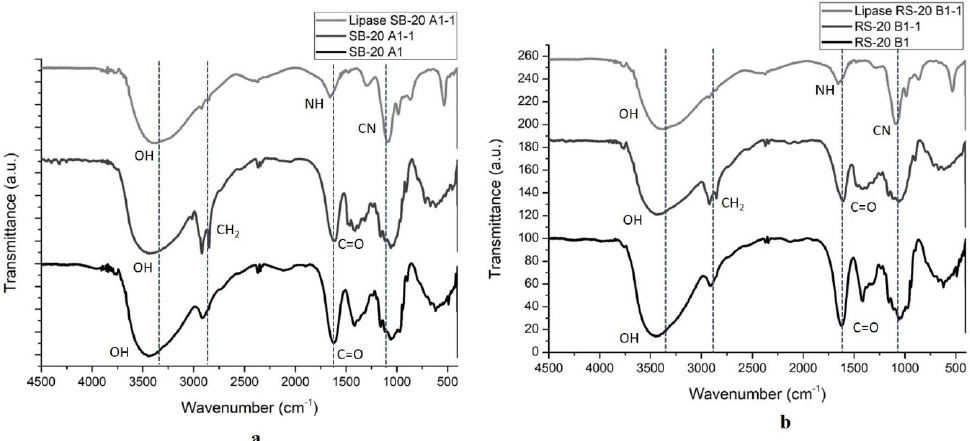
Figure 6. FTIR spectra of unmodified CNC, modified CNC, and the immobilized lipase: ( a ) unmod- ified CNC (SB-20 A1) and modified CNC (SB-20 A1-1) from sugarcane bagasse, and immobilized lipase (Lipase SB-20 A1-1); ( b ) unmodified CNC (RS-20 B1) and modified CNC (RS-20 B1-1) from rice straw and immobilized lipase (Lipase RS-20 B1-1).